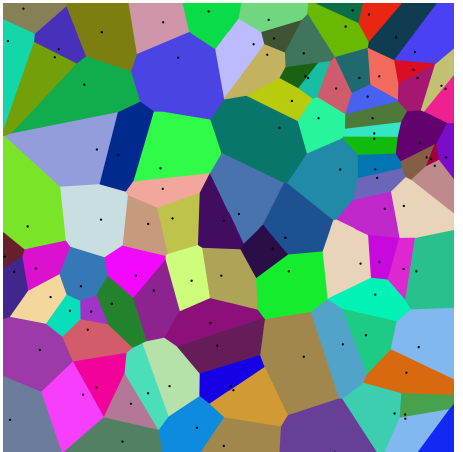
Figure 2. An illustration space partitioning in approximate nearest neighbor. The black dots represent the vectors, and each partitioning of the space is shown in a different color. Credit: https://en. wikipedia.org/wiki/File:Coloured_Voronoi_2D.svg (accessed on 9 September